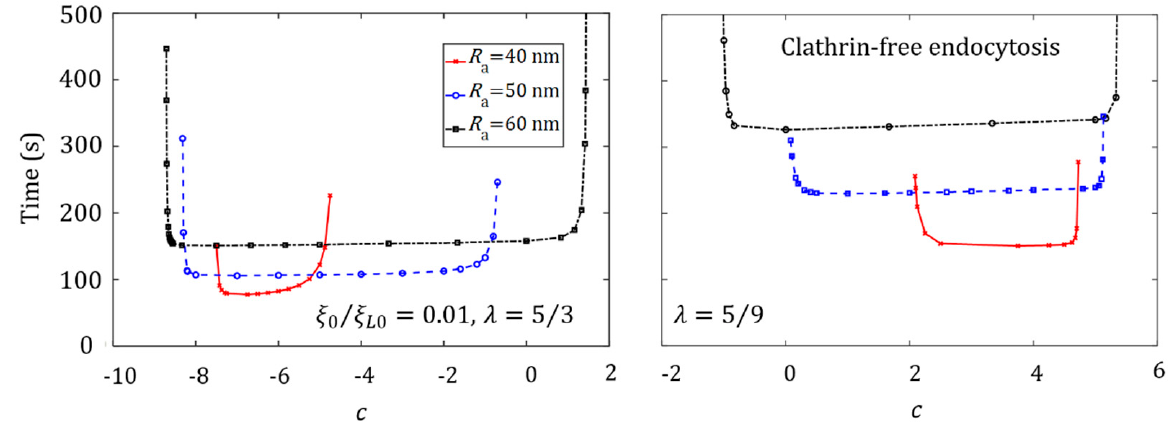
Figure 8. Wrapping time as a function of the degree of non-uniformity of ligand distribution, c , for different NP sizes, during the cellular uptake of oblate ellipsoid ( λ = 5/3) and elongated NPs ( λ = 5/9) via membrane-mediated endocytosis, with ξ 0 = 0.01 ξ L 0 .